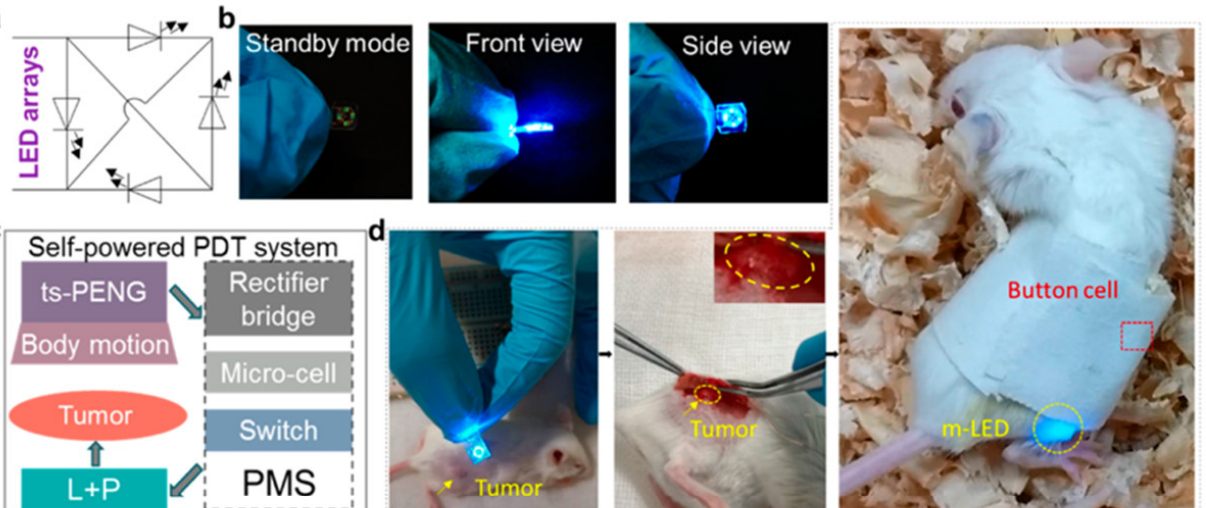
Figure 28. Experimental results of intermittent continuous light stimulation applied to a tumor in vivo [113]. ( a ) Electrical diagram of LED array. ( b ) Different views and states of the LED array pack- aging by PDMS. ( c ) Schematic diagram of the self-powered PDT system. ( d ) Application of the self- powered PDT system to inhibit a tumor model on a rat. ( e ) Variation of the tumor volume using a control group without any treatment and experimental groups cultured with porphyrin, LED, and LED + porphyrin. ( f ). Results of tumor growth multiplication during 12 days of a control group without any treatment and experimental groups cultured with porphyrin, LED, and LED + porphy- rin. ( g , h ) Photographs of the tumors and pathological section (50 μm of scale bar) obtained from different experimental groups. These results were measured after 12 days. Reprinted with permis- sion from [113]. Copyright 2020, American Chemical Society.